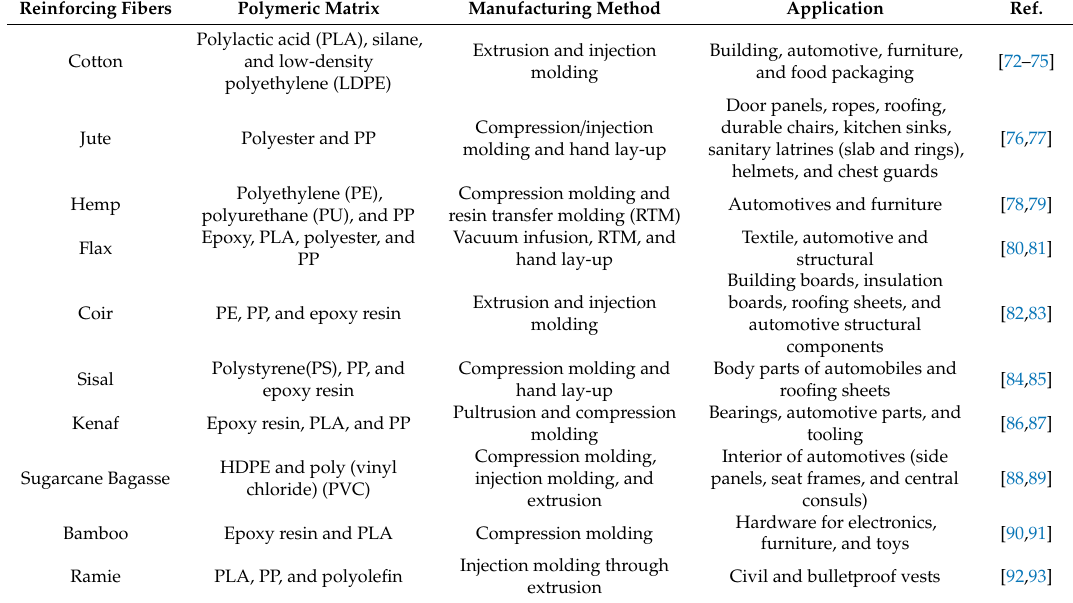
Table 4. Application, manufacturing method, and matrix materials of some potential natural fibers. Reinforcing